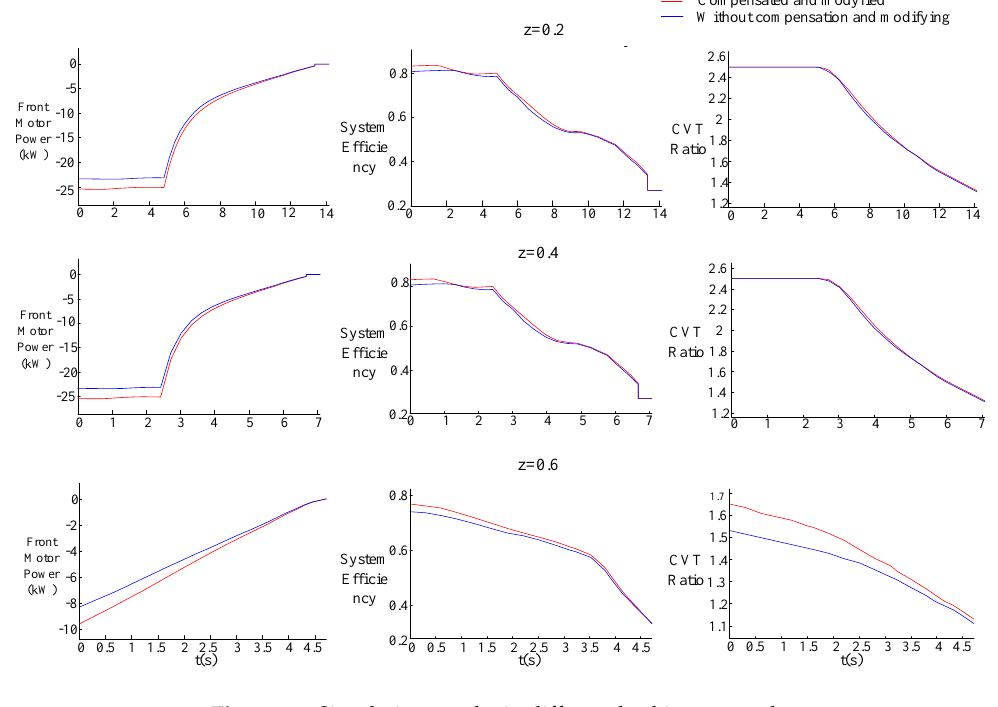
Figure 13. Simulation results in different braking strength.